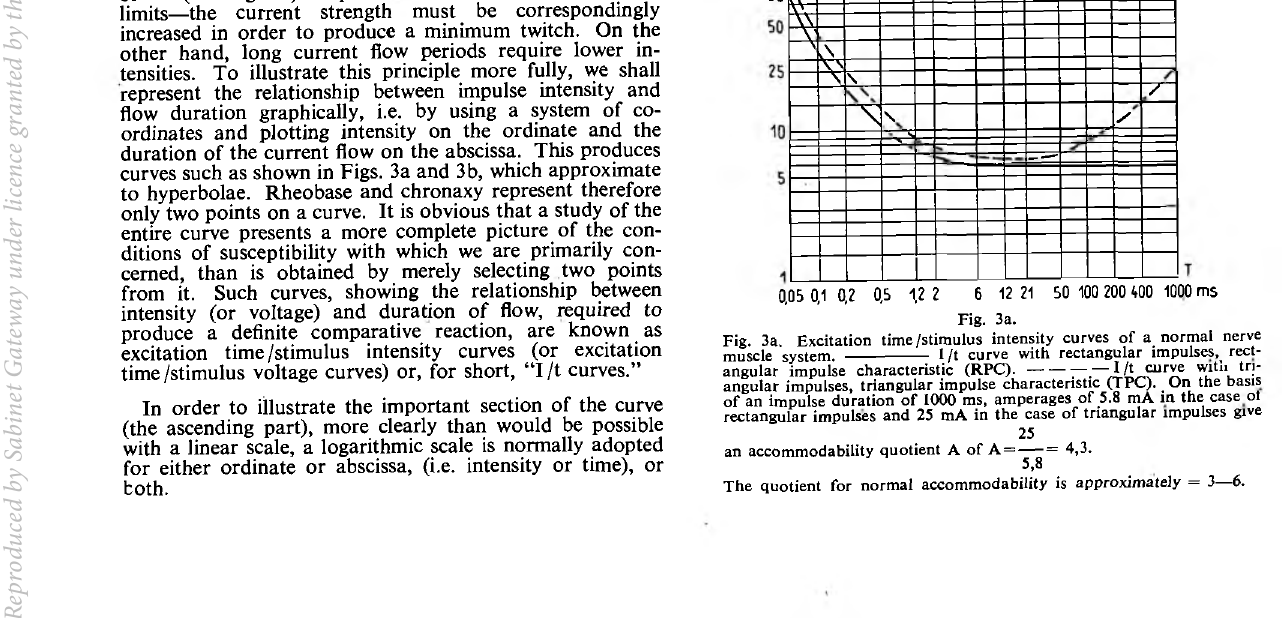
Fig. 3a. Fig. 3a. Excitation time/stimulus intensity curves of a normal nerve muscle system. I/t curve with rectangular impulses, rect- 111 Li OW1W djdlvlll* / • w w w , angular impulse characteristic (R PC ).--------—#— I /t curve wit" *r]" angular impulses, triangular impulse characteristic (TPC). # On the basis of an impulse duration of 1000 ms, amperages of 5.8 mA in the case